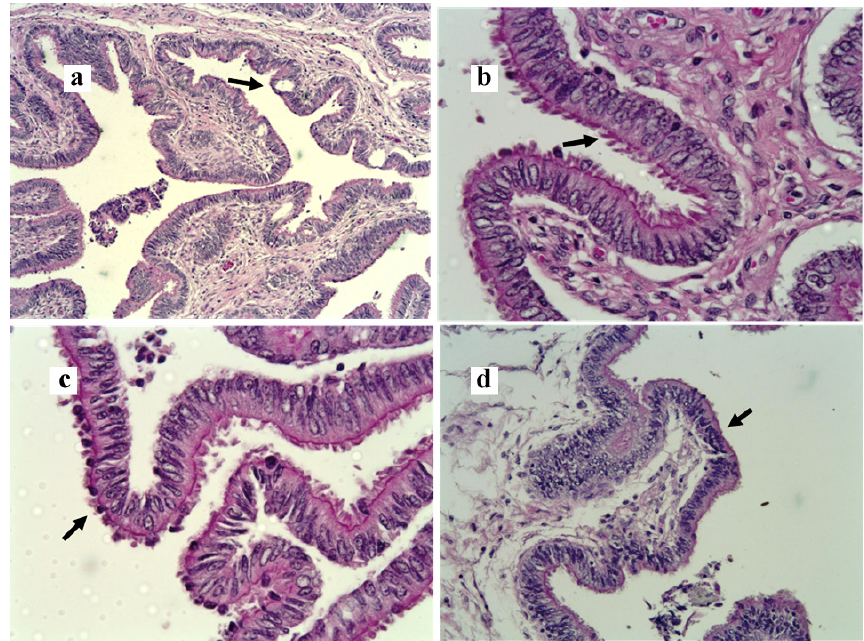
Figure 1 - Photomicrography. Uterine tube. Panel a - infundibulum, intraepithelial vesicles (narrow, H&E, 200X); Panel b - Infundibulum, curvature of cilia (narrow, H&E, 400X); Panel c - Ampola, decilition (narrow, H&E, 200X); Panel d - Isthmus, epithelial cells with cytoplasmatic projection (narrow, H&E, 400X).